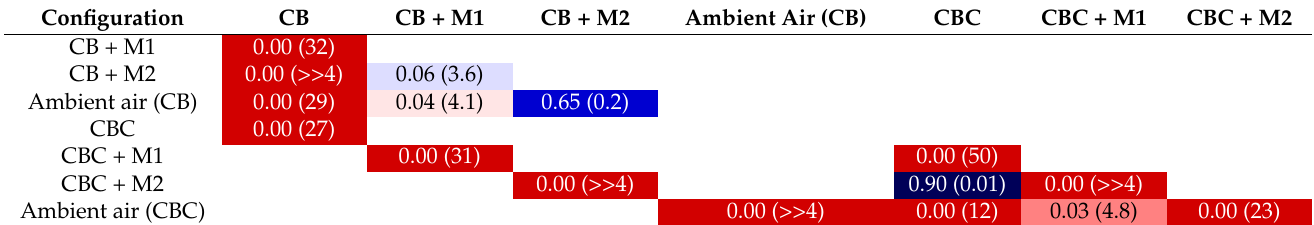
Table 4. Heatmap showing results of the Mood’s median test ( p -values and χ 2 in parenthesis), performed to test the null hypothesis that the medians of two series of fungal concentration in treated gases/ambient air were identical. For the detailed legend, see Table